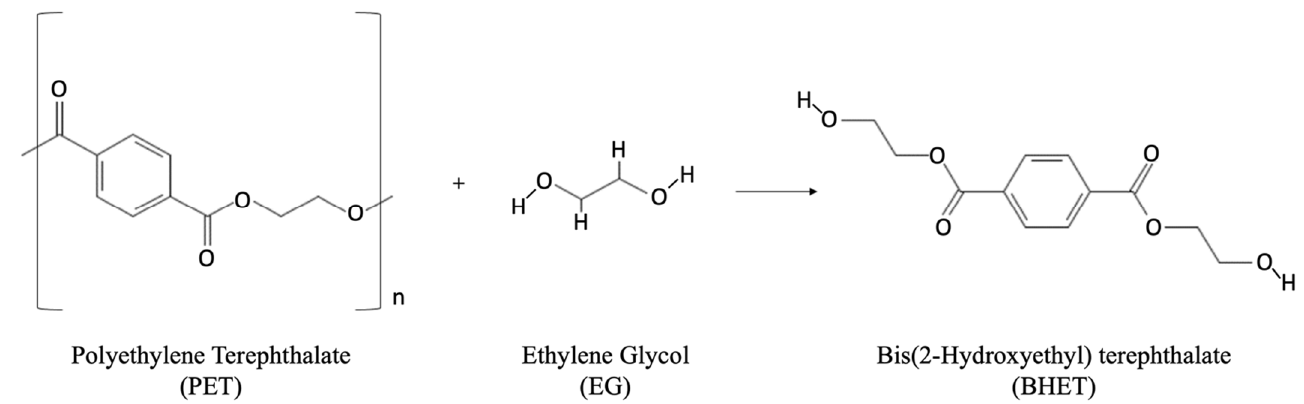
Figure 5. Glycolysis chemical reaction of PET with ethylene glycol to produce BHET.